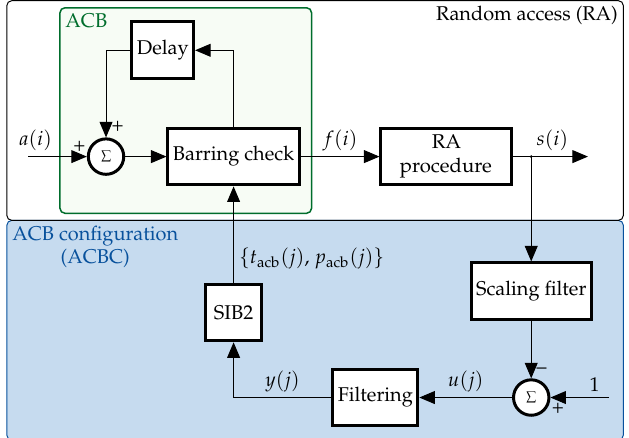
Figure 2. Block diagram of the RAP with our ACBC scheme. The random access is performed at each RAO, whereas the ACBC can only be performed once every t si